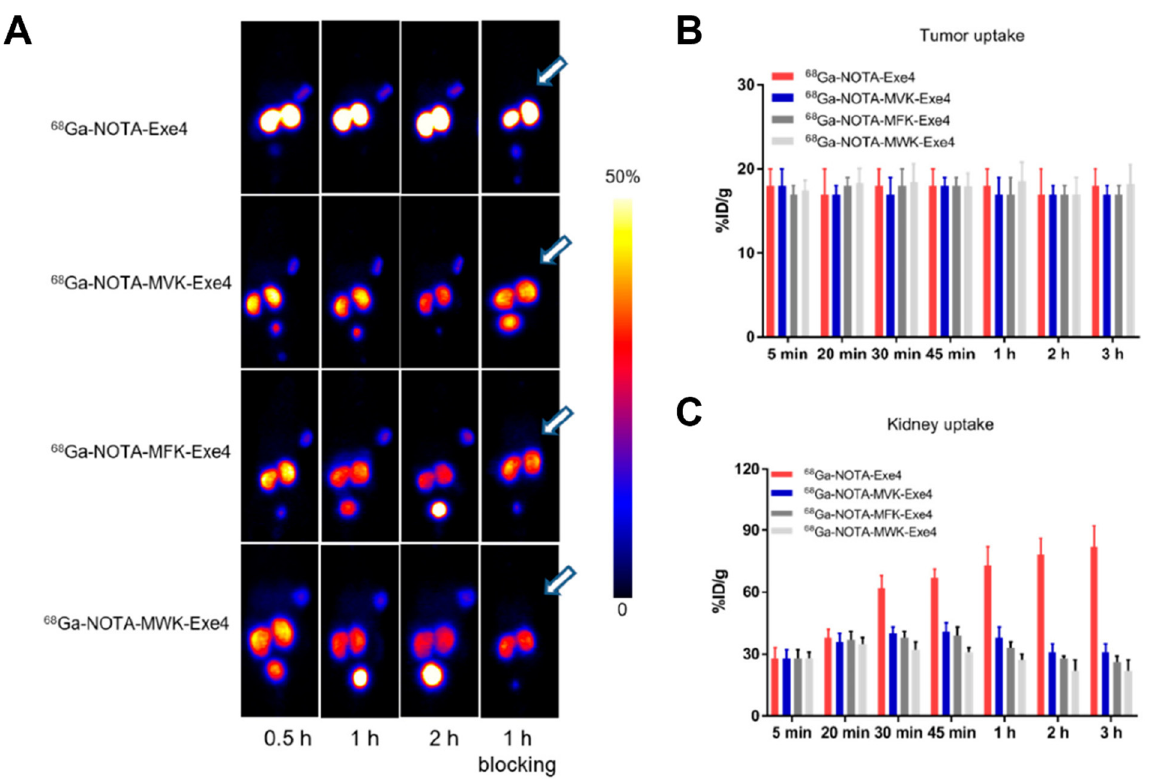
Figure 6. PET images of 68 Ga-labeled exendin-4 derivatives ( A ). Quantification of kidney ( B ) and tumor ( C ) uptake in INS-1 tumor-bearing mice. Reprinted with permission from ref. [69]. Copyright 2021 American Chemical Society.